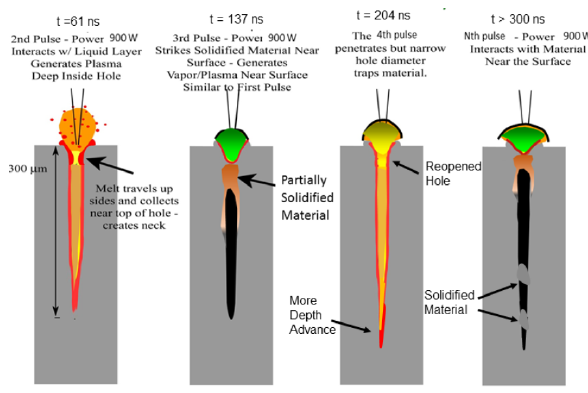
Figure 5: Subsequent process anatomy with multiple pulse